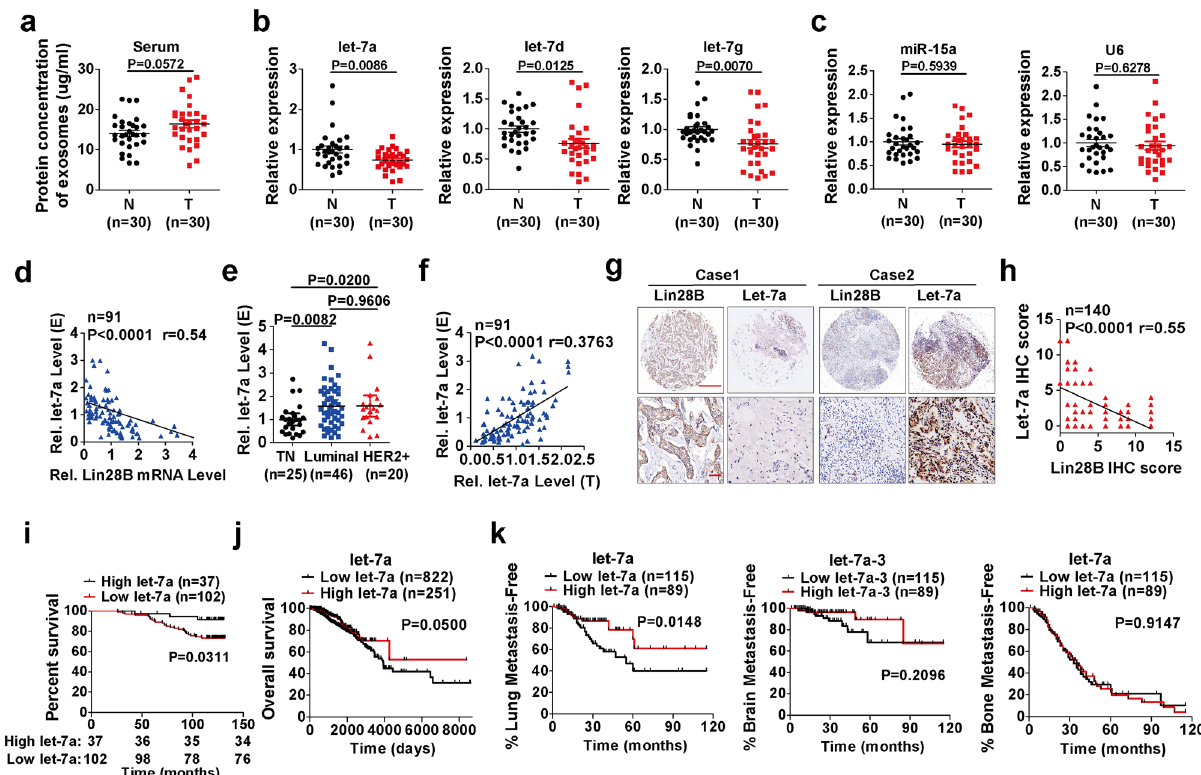
Fig. 8 Serum exosomal let-7s correlate with Lin28B expression of primary tumors and are potential indicators for predicting breast cancer patient prognosis. a Exosome protein concentrations puri fi ed from sera of healthy donors and primary breast cancer patients ( n = 30 patients). b Let-7a, let-7d, and let-7g were quanti fi ed by qRT-PCR in exosomes prepared as in panel a . MiR-16 served as an internal control ( n = 30 patients). c Mir-15a and U6 expression in exosomes prepared as in panel a . MiR-16 served as an internal control ( n = 30 patients). d Pearson correlation between the relative Lin28B mRNA level of primary tumors and the relative let-7a amount of serum exosomes in the same breast cancer patient ( n = 91 patients). e Relative